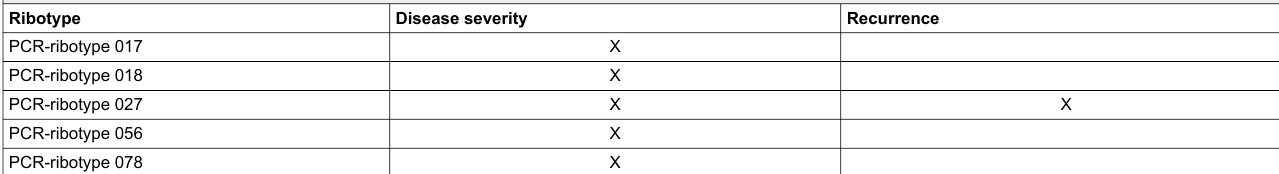
Table 2: Suggested associations between different ribotypes with disease severity and recurrence.